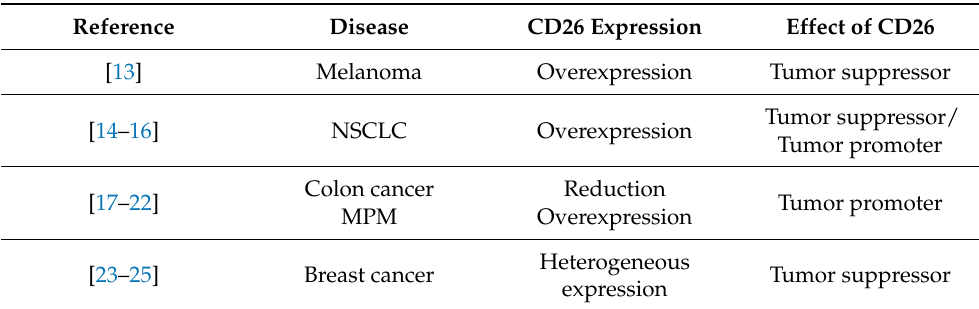
Table 1. Summary of clinical and biological studies that investigated the role of CD26 expression in different types of